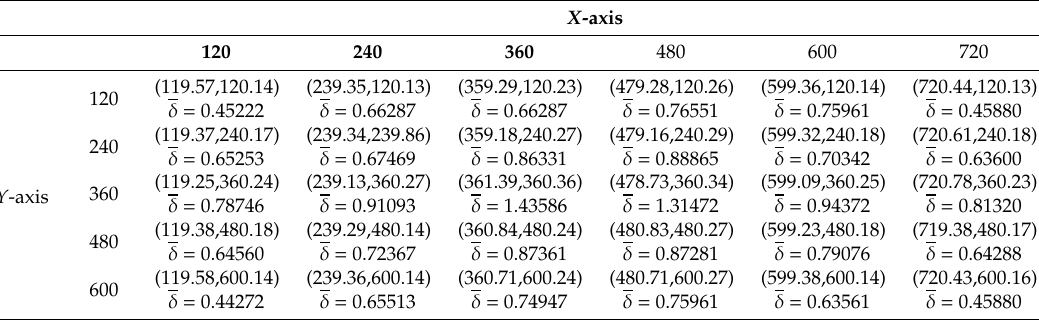
Table 2. Camera localization average error at each coordinate point.